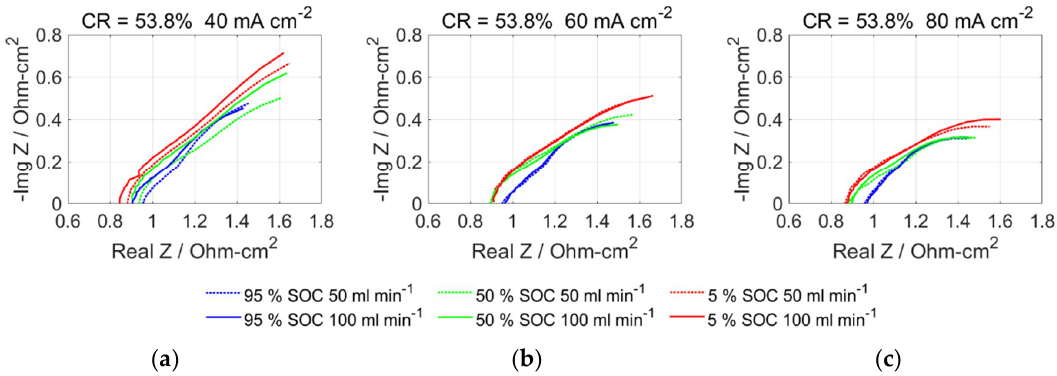
Figure 7. Nyquist plots of EIS of the VRFB under various operating conditions at CR = 53.8%: ( a ) 40 mA cm − 2 ; ( b ) 60 mA cm − 2 ; ( c ) 80 mA cm − 2 .